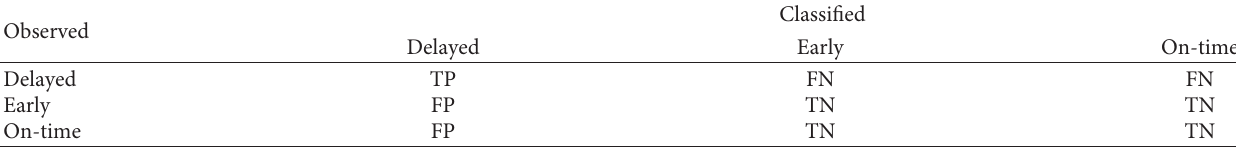
Table 2: The sample confusion matrix for positive class (delayed) and negative class (early and on-time).